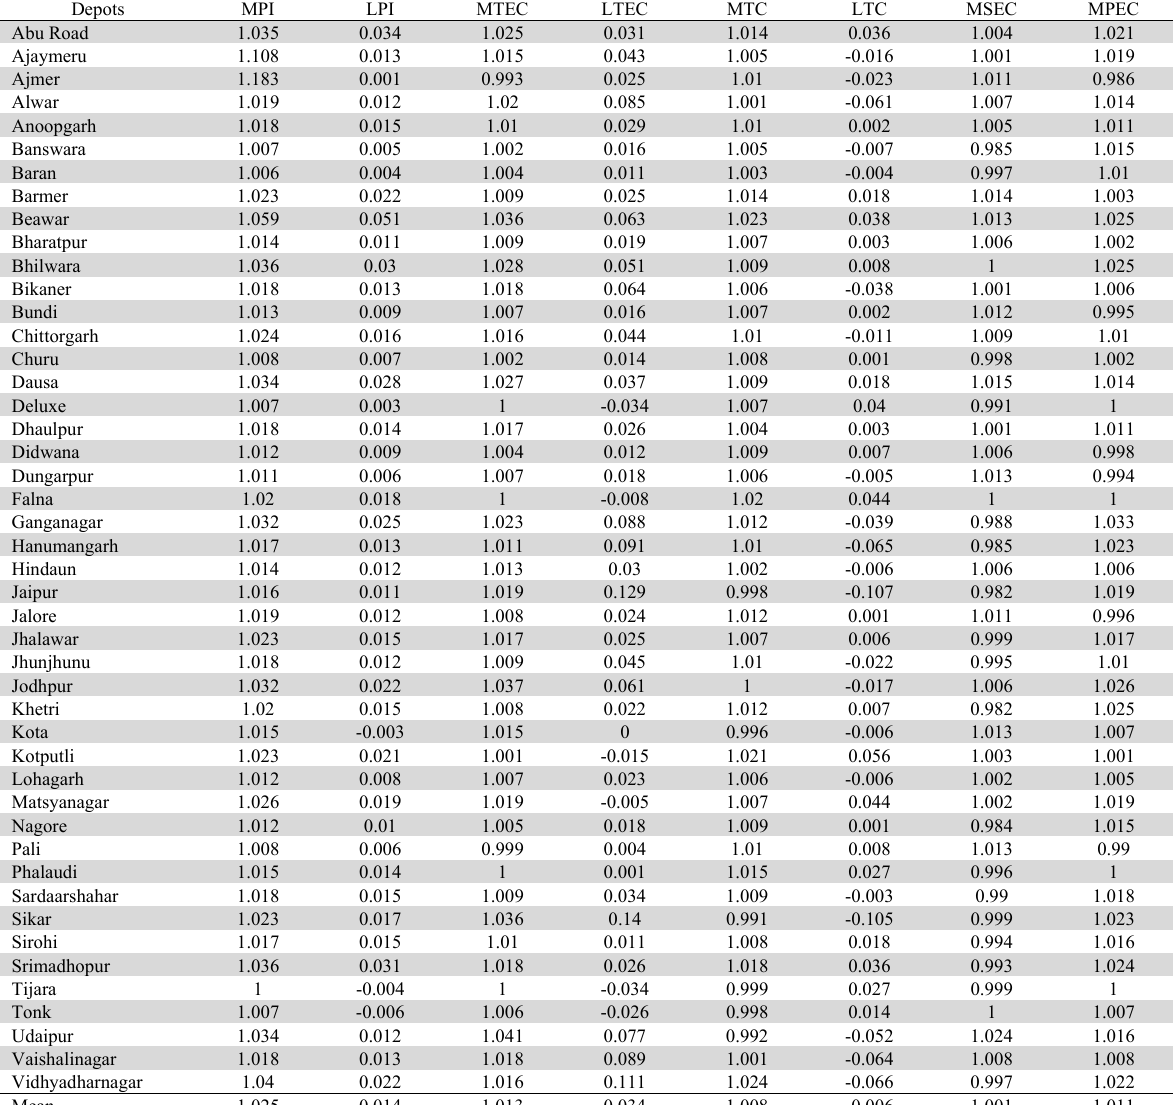
Table 3 Productivity Performance Values of NSM MPI and LPI